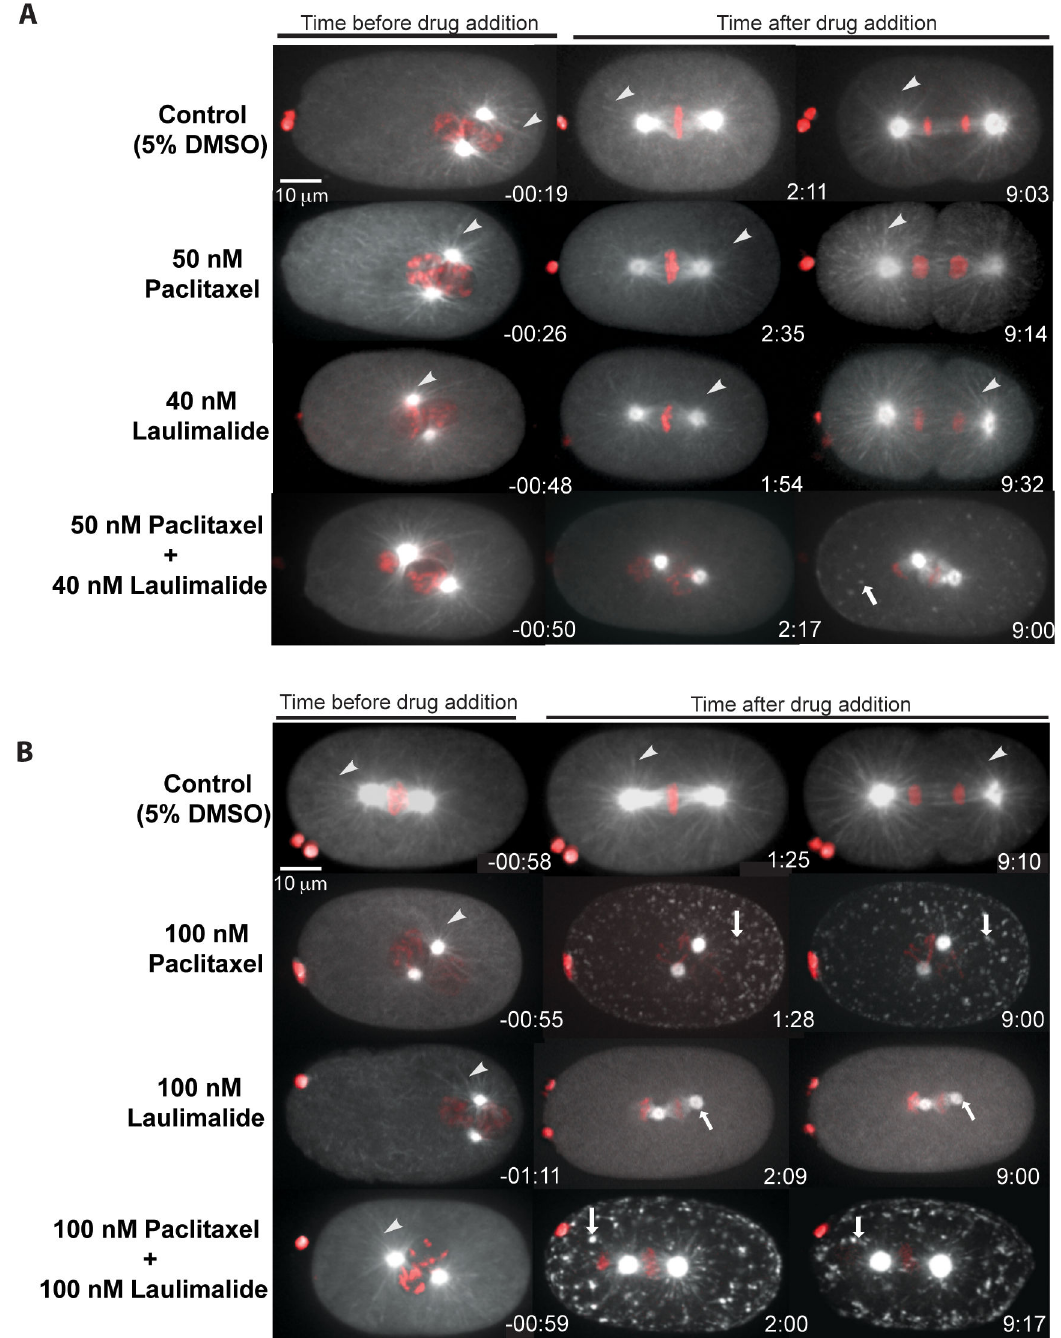
Figure 5. Laulimalide and paclitaxel act synergistically. A) Embryos treated with 5% DMSO (control), 50 nM paclitaxel or 40 nM laulimalide all exhibited normal cell division. White arrowheads indicate microtubule fibres, which were observed in all time frames. Embryos were also treated with a mixture 40 nM laulimalide and 50 nM paclitaxel, resulting in the appearance of tubulin aggregates (white arrows). A small spindle-like structure was observed, however, the morphology was abnormal and chromosome segregation did not occur. B) Embryos treated with 100 nM paclitaxel and 100 nM laulimalide show evidence of microtubule stabilization and destabilization respectively. Embryos treated with a mixture of laulimalide (100 nM) and paclitaxel (100 nM) displayed aggregates of tubulin (white arrows) and phenotypes similar to those observed with high doses of paclitaxel alone.